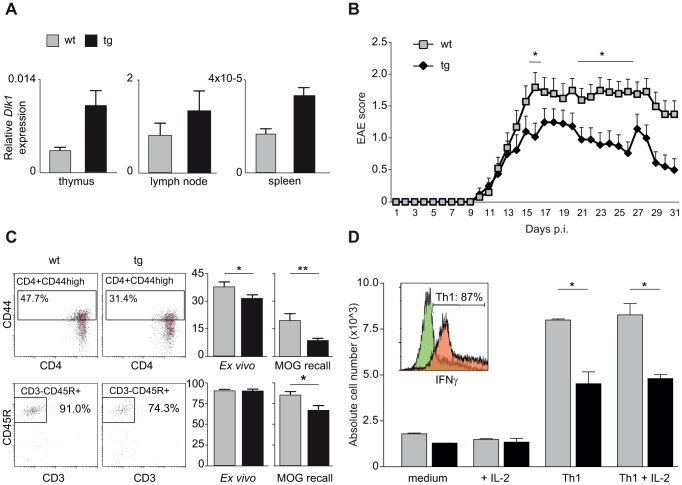
Transgenic overexpression of Dlk1 modulates EAE severity and adaptive immune responses.A) Dlk1 mRNA expression in immune tissues in Dlk1 transgenic and wild type littermate control mice measured using TaqMan PCR. Relative Dlk1 expression was calculated in relation to the mean of housekeeping gene, beta-2 microglobulin, using 2-ΔΔCt method (N = 3–5 mice/group). B) Daily EAE scores in Dlk1 transgenic (N = 24) and wild type littermate control (N = 20) mice after immunization with MOG demonstrate that the higher levels of Dlk1 in transgenic mice are protective against EAE. Mean EAE clinical score (and the standard error of the mean) is given for each day post immunization (p.i.). The figure represents pooled data from three separate experiments. Mann-Whitney U-test was used to compare the daily EAE scores (p-value <0.05  =  *). C) Flow cytometry analysis of percentages of activated T helper cells (CD3+CD4+CD44+) and B cells (CD3-CD45R+) in spleen tissue 25 days after EAE induction, ex vivo and after 48 hour of restimulation with MOG (MOG recall). Transgenic Dlk1 mice displayed lower percentage of activated T cells and B cells compared to wild type littermate controls (N = 7/group). D) Flow cytometry analysis of numbers of differentiated IFN-γ producing Th1 cells (details in Materials and Methods). Transgenic Dlk1 mice showed a lower number of Th1 cells in comparison to wild type littermates (N = 2/group, three independent experiments). Green and orange histograms show IFN-γ producing cell population in control and fully Th1 differentiated conditions, respectively.